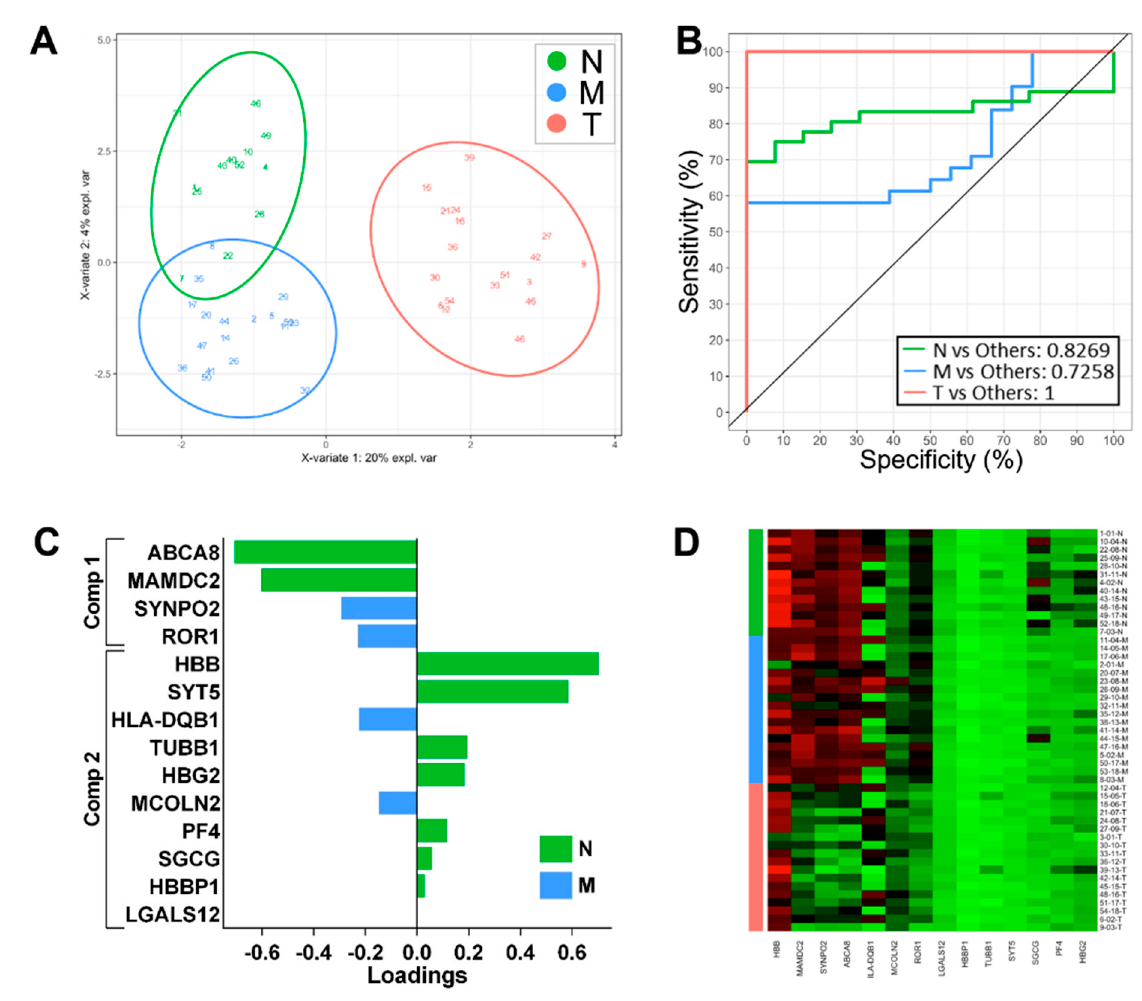
Figure 1. Classification performance sPLS-DA-derived gene expression signatures on all sample groups: N vs. M vs. T. ( A ) Two-dimensional sample plots for the multinomial classifier for 3 groups with confidence ellipse plots. ( B ) Corresponding ROC curves. ( C ) Loading plots for multinomial N vs. M vs. T classifiers showing the contribution of each gene to the signature. ( D ) Heatmap of the gene expression across all samples for the multinomial N vs. M vs. T classifiers.